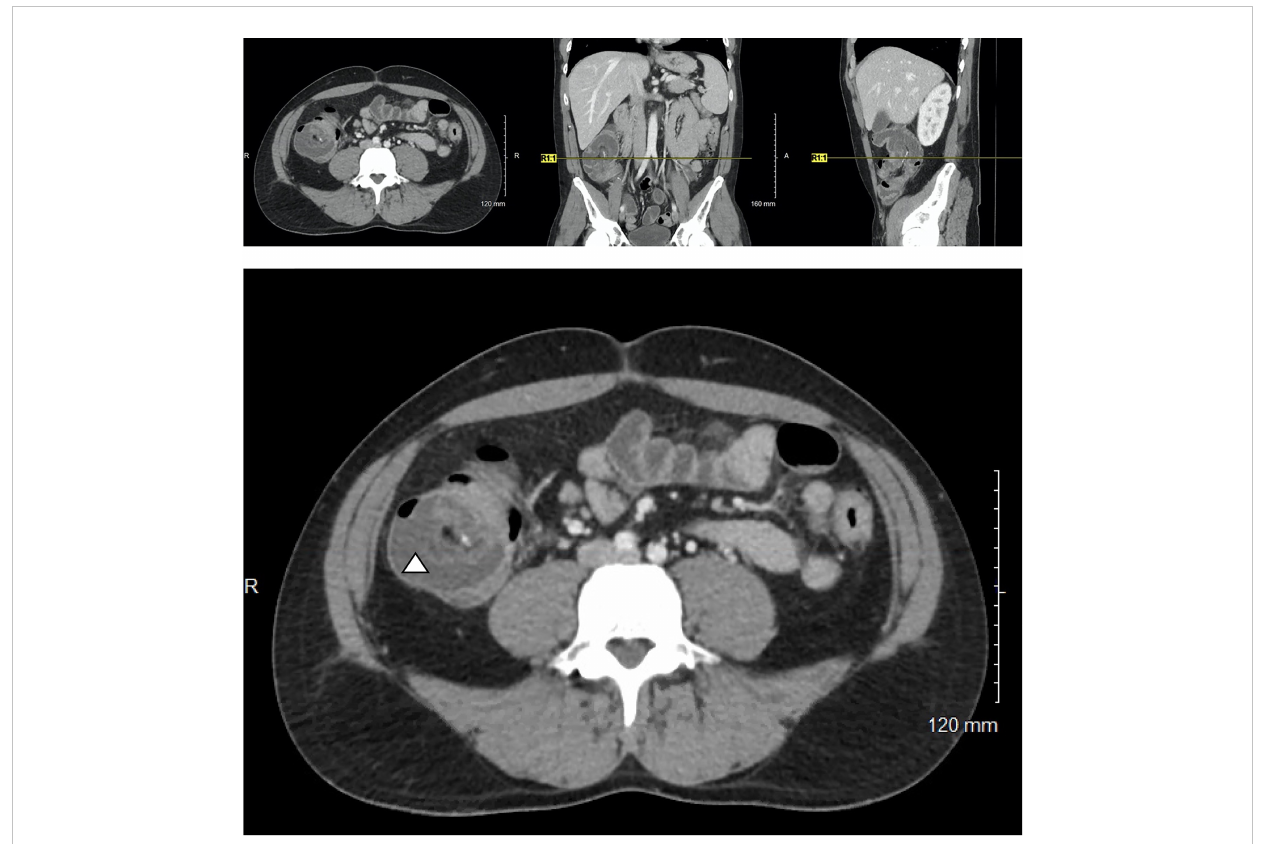
FIGURE 2 Cross-sectional imaging of a 37-year-old M with Stage IV in-transit melanoma receiving immune checkpoint inhibitor therapy who presents with severe abdominal pain. A characteristic target-sign for intussusception is appreciated in cecum (triangle) and can be seen on the axial, coronal, and sagittal